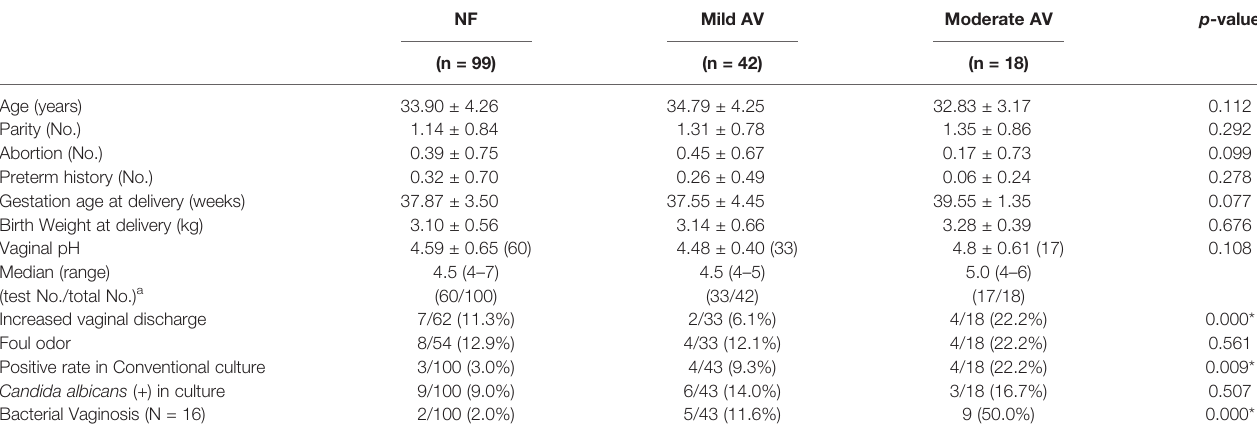
TABLE 1 | The demographic characteristics of pregnant women with the aerobic vaginitis